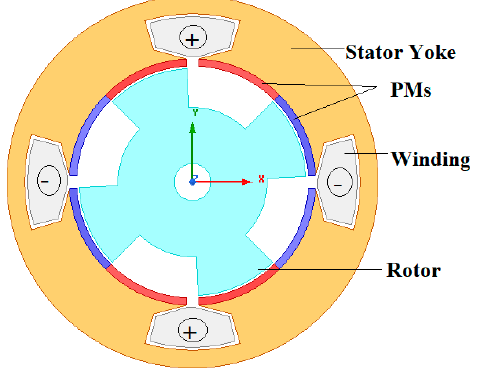
Figure 11. 3-phase, 6-stator-pole/8-rotor-pole FRM [29].